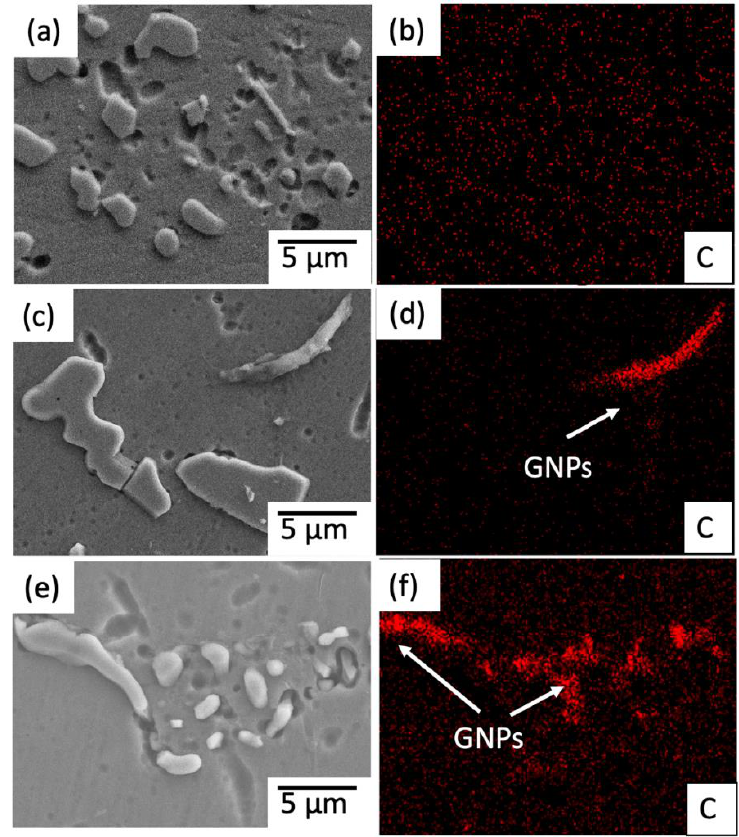
Figure 7. SEM images and their respective C element of thixoformed microstructure ( a , b ) 0.3 wt.% GNPs, ( c , d ) 0.5 wt.% GNPs, ( e , f ) 1.0 wt.% GNPs/Al composite with their respective C element.